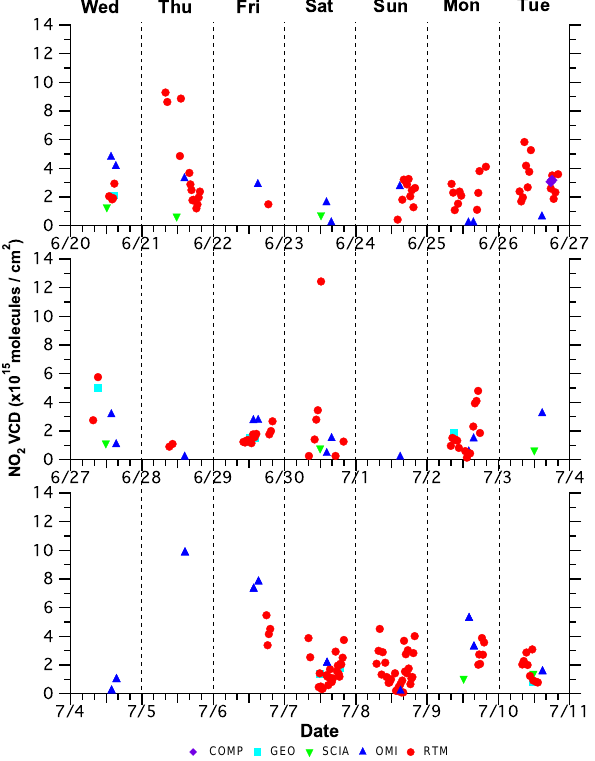
Fig. 10. Comparison of all NO 2 tropospheric VCDs at Ridgetown derived from aircraft/ground, satellite, and MAX-DOAS-RTM measurements.